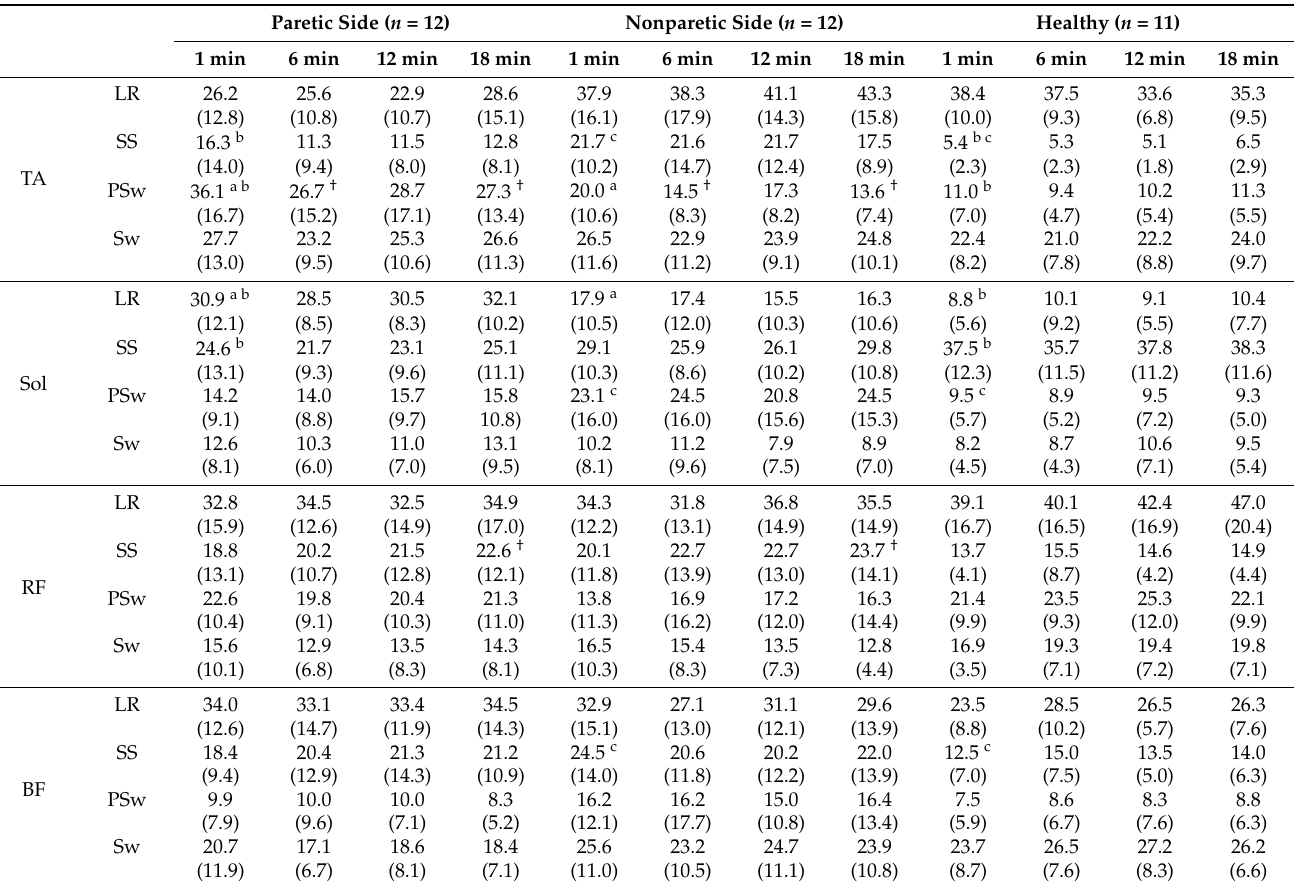
Table 3. Electromyography amplitude changes over time during the extended walking